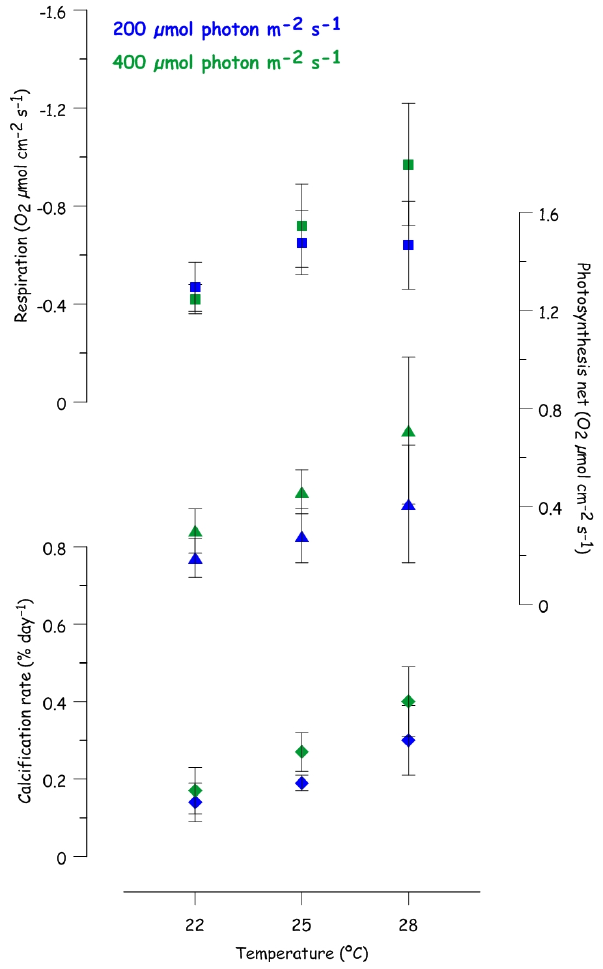
Fig. 2. Mean respiration (O 2 µmolcm − 2 s − 1 ) , photosynthesis (O 2 µmolcm − 2 s − 1 ) and calcification (% day − 1 ) rates measured per experimental conditions and plotted vs. temperature (error bars Figure 2 represent SD). Mean respiration (O μmol cm -2 s -1 ), photosynthesis (O μmol cm -2 s -1 ) and calcification (% 2 2 day -1 ) rates measured per experimental conditions and plotted versus temperature (error bars represent SD).